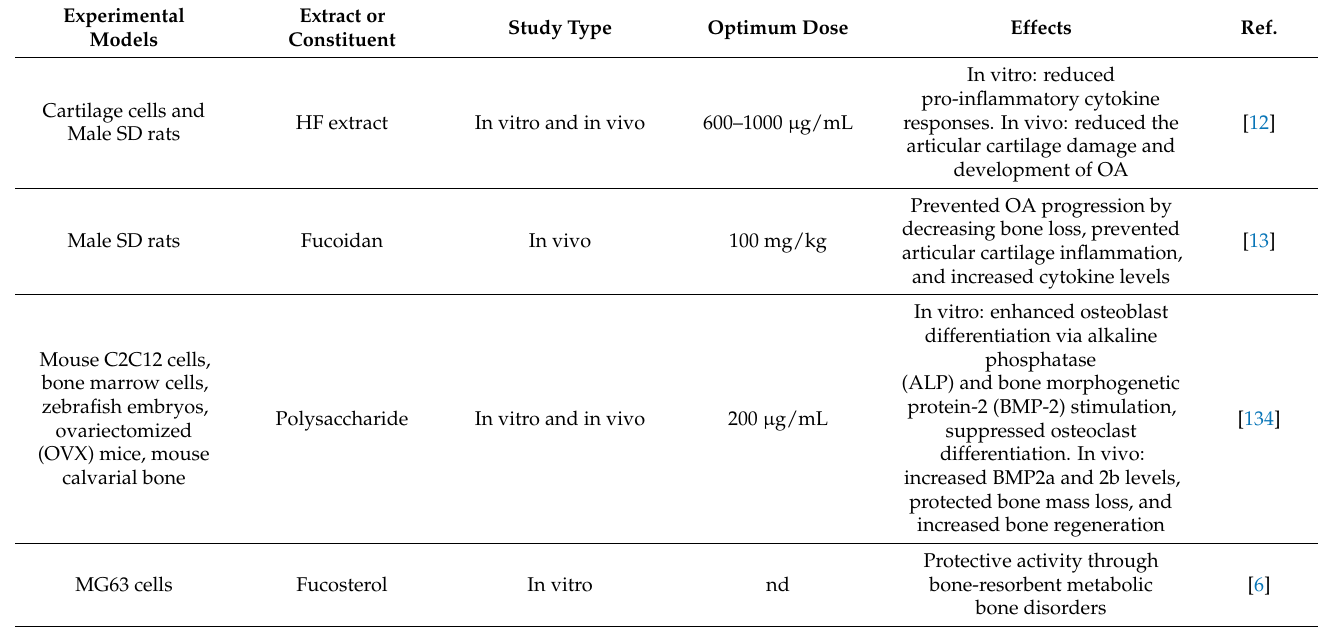
Table 13. Summary of osteoprotective activity of H. fusiformis .